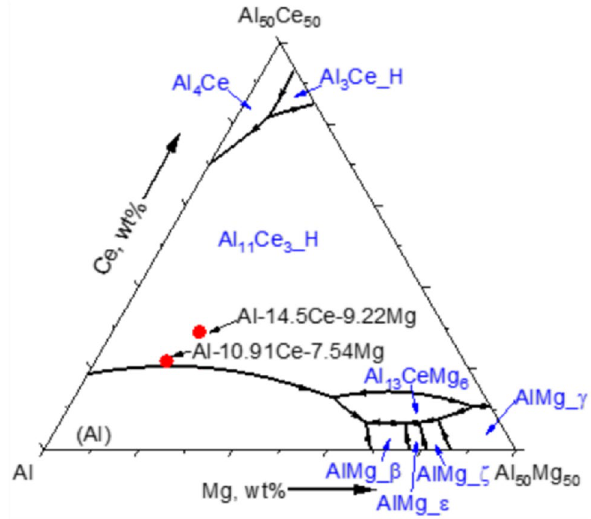
Figure 9. Calculated liquidus projection in the Al-rich region of the Al–Ce–Mg ternary system.